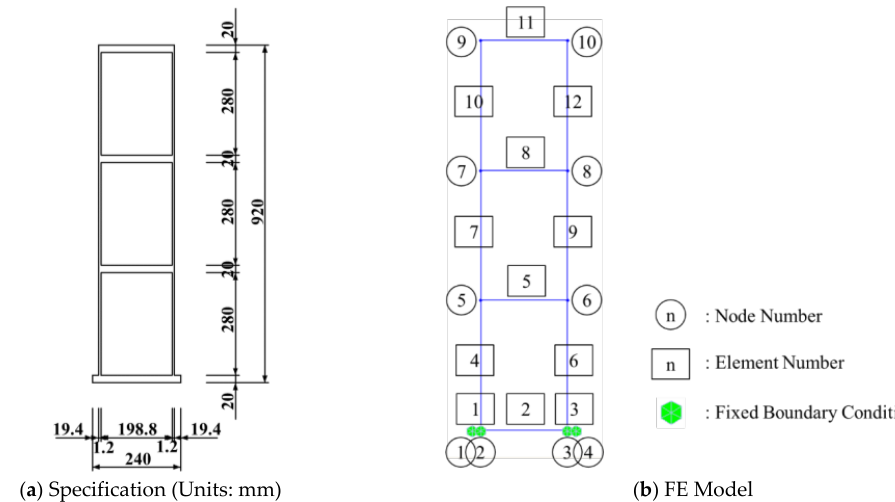
Figure 6. FE model used for model updating.